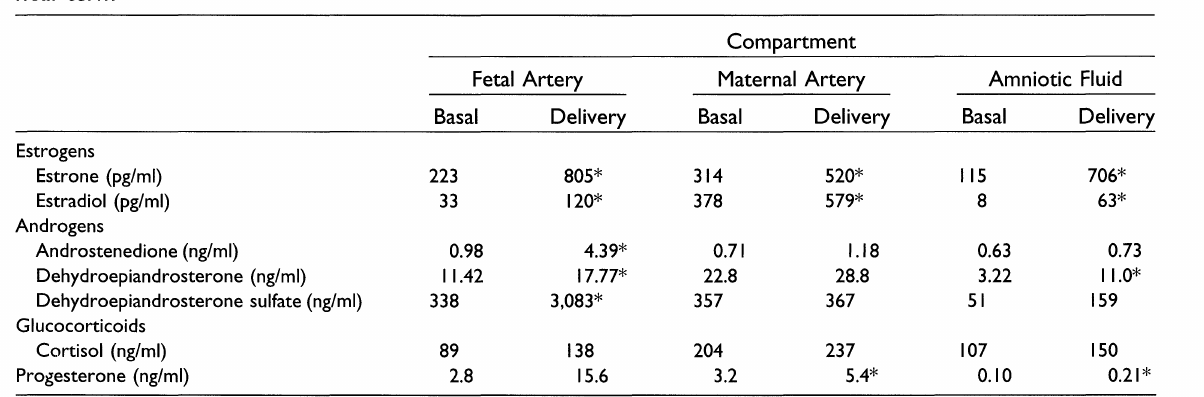
TABLE 3. Median steroid hormone concentrations among rhesus monkeys (n 4) in spontaneous parturition near term